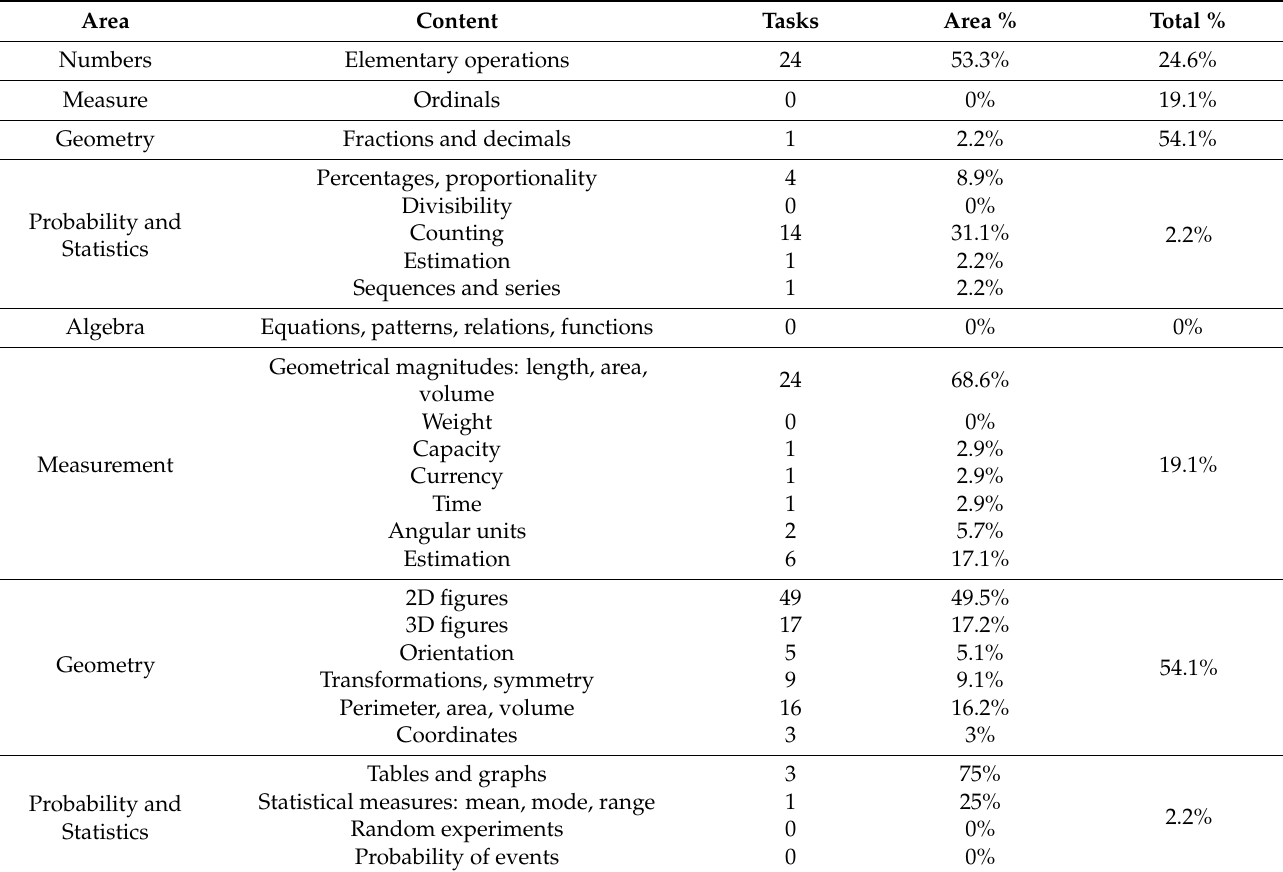
Table 3. Mathematical content of the tasks.